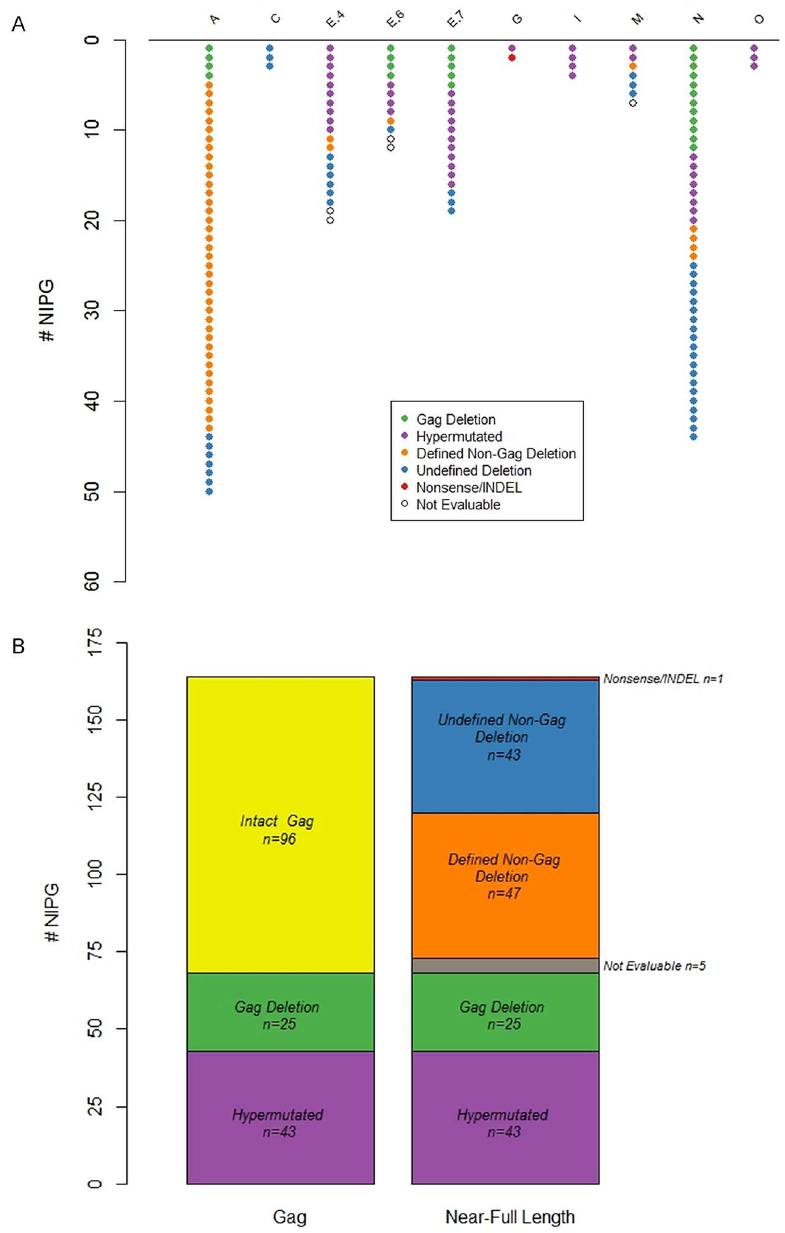
Fig 2. Classification of NIPG. (A) Distributionof NIPG within each study participant. Purple: hypermutation; Green: Gag deletion;Red: intact near-fulllength, replication-deficient due to nonsensemutations or INDELs; Blue: undefined non-Gag deletion; Orange: definednon-Gagdeletion;empty circle: not evaluable.(B) Distributionof NIPG across study participantsafter Gag and near-fulllength sequencing. NIPG : non-induced proviralgenomes